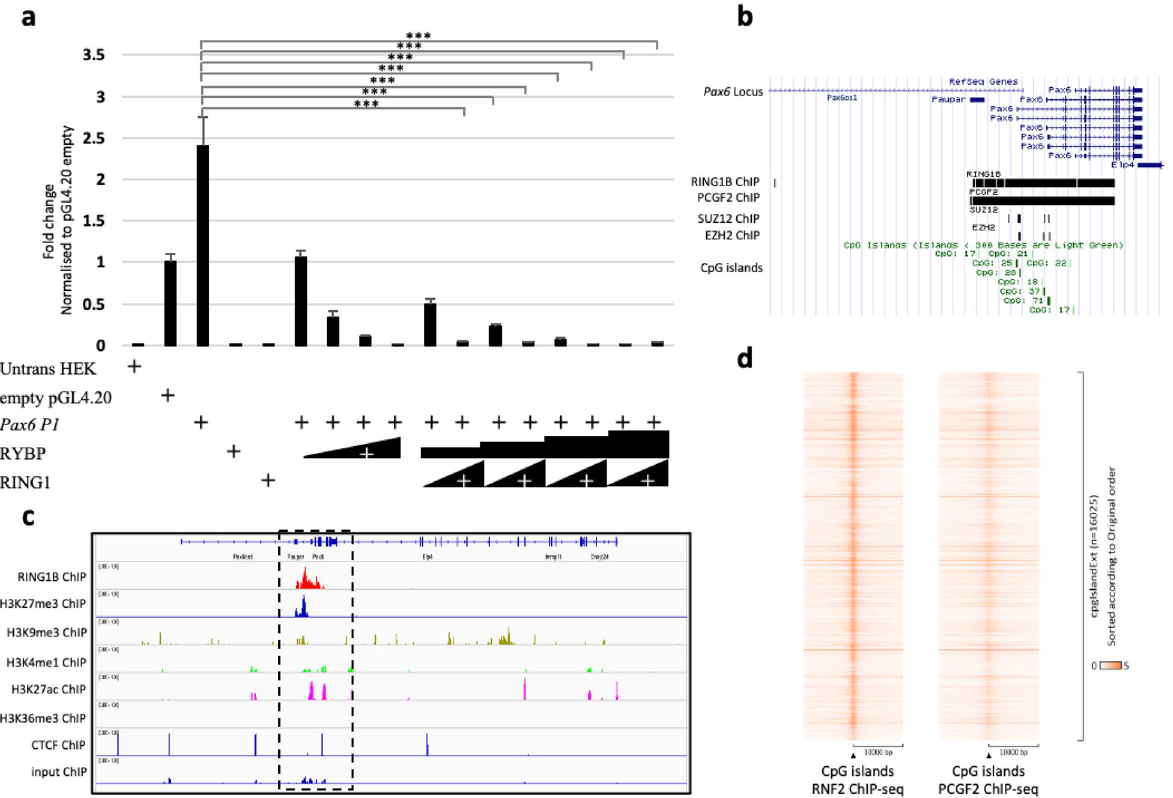
Figure 7. RYBP represses Pax6 gene expression in a polycomb dependent way. ( a ) Luciferase assays were performed in HEK293 cells transiently transfected with mouse Pax6 P1 promoter reporter (pGL4.20 Pax6 P1 ) or with empty vector (pGL4.20), RYBP and RING1 expression plasmids in increasing dosages ( Rybp : 1 µg, 5 µg, 10 µg, 20 µg; Ring1 : 1 µg, 10 µg) Values are expressed as fold changes of luciferase activity normalized to the empty vector. The presented values are averages of three independent experiments. Means are standard deviation ± SD. Values of p < 0.05 were accepted as significant (* p < 0.05; ** p < 0.01; *** p < 0.001, n = 3). Statistical method: t test type 3. ( b ) UCSC genome tracks showing ChIP-seq binding of PRC1 factors RING1 (GSM1917303), PCGF2 (GSM1917304), and PRC2 factors SUZ12 (GSM1917301) and EZH2 (GSM1917302) 39 . ( c ) The methylation state of Pax6 genomic locus in NPCs determined by the histone modifications present using existing ChIP-seq data from Bonev et al., 2017 55 . The binding of RNF2 (GSM2533860), H3K27me3 (GSM2533864), H3K9me3 (GSM2533866), H3K4me1 (GSM2533862), H3K27ac (GSM2533868) and H3K36me3 (GSM2533870) are displayed in reference to CTCF (GSM2533858) and input (GSM2533871). The Pax6 P1 promoter (highlighted in dotted box) displayed bivalency presenting both repression histone marks (H3K27me3 and H3K9me3) and activation histone mark (H3K27ac) in NPCs. ( d ) The peak density heat map of the genome wide binding targets of RNF2 and PCGF2 integrated with the global position of the CpG islands in NPCs. Untrans HEK Untransfected HEK293